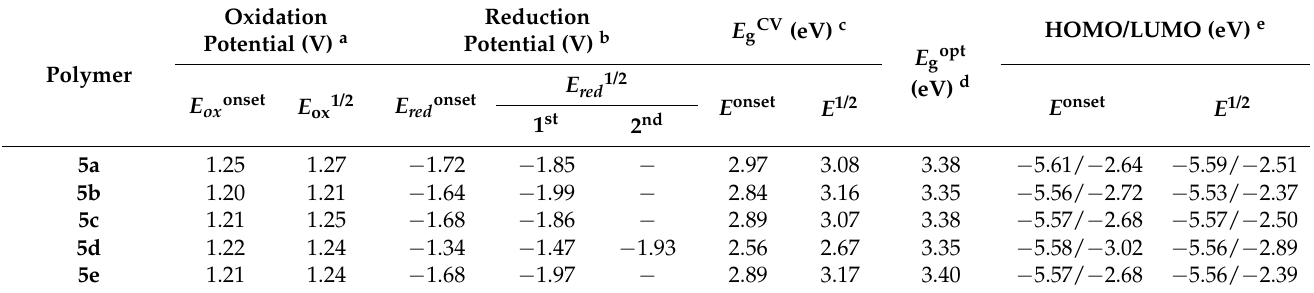
Table 4. Redox potentials and energy levels of polyamides.